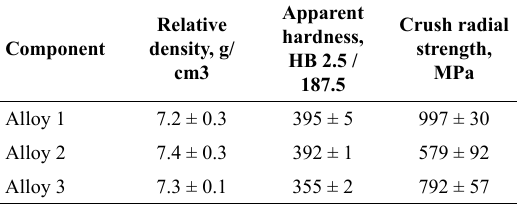
Table 3. Mechanical and physical properties of the VSIs obtained with Alloy 1 (AISI M3:2 powder mixture), Alloy 2 (AISI M2 powder mixture) and Alloy 3 (AISI D2 powder mixture) air quenched and double tempered at 600 °C, 600 °C and 500 °C, respectively